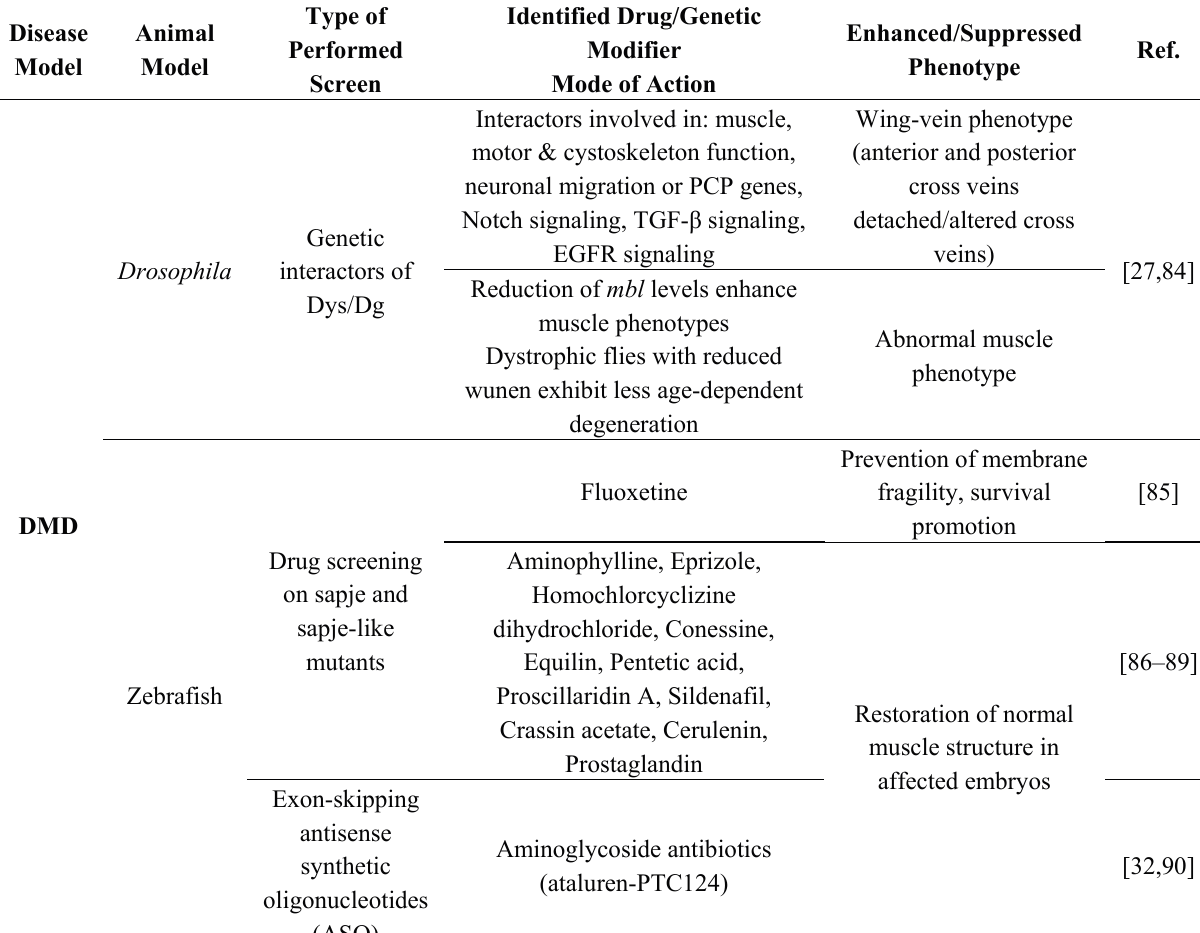
Table 2. Screens performed in Drosophila and zebrafish MD